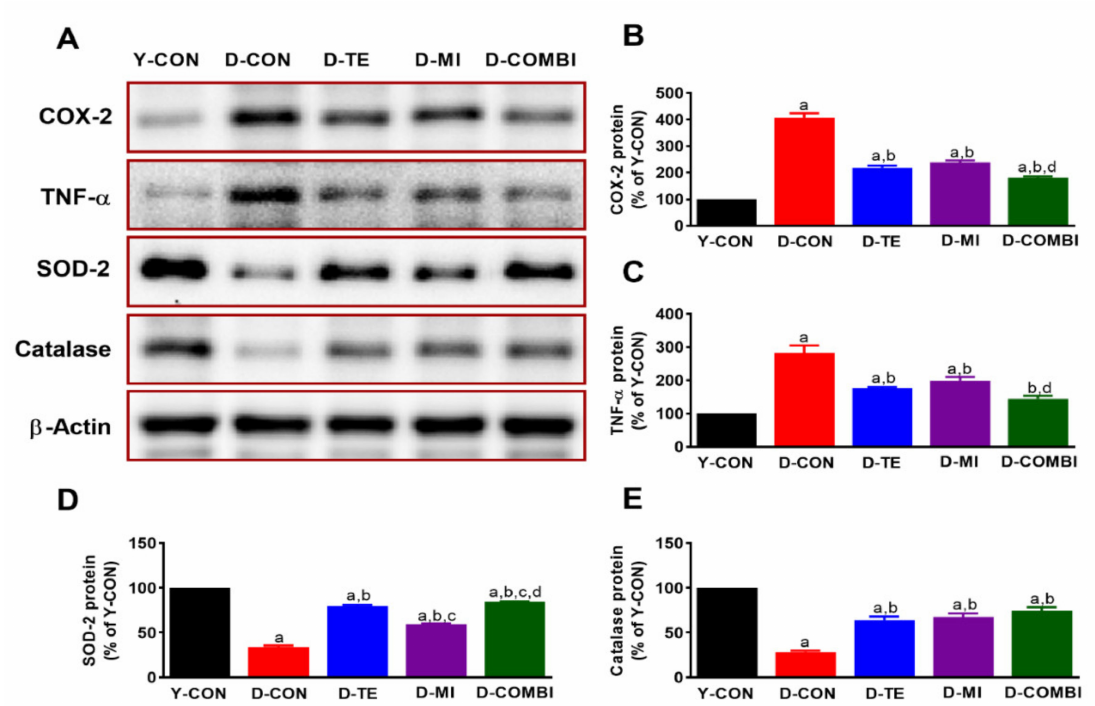
Figure 4. Effect of treadmill exercise and MitoQ on the expression of inflammatory proteins and antioxidant enzymes in the hippocampus of D-gal induced aging rats. ( A ) Representative Western blots of inflammatory proteins (COX-2, TNF- α ) and antioxidant enzymes (SOD-2, Catalase). ( B – E ) Densitometric analysis of the Western blot bands normalized to β -Actin. The data shown in the Western blot are means from seven rat brains. β -Actin was probed as an internal control. Bonferroni post hoc test was used after ANOVA. Values are means ± SEM. a Denotes statistical difference from the Y-CON group. b Denotes statistical difference from the D-CON group. c Denotes statistical difference from the D-TE group. d Denotes statistical difference from the D-MI group ( p <